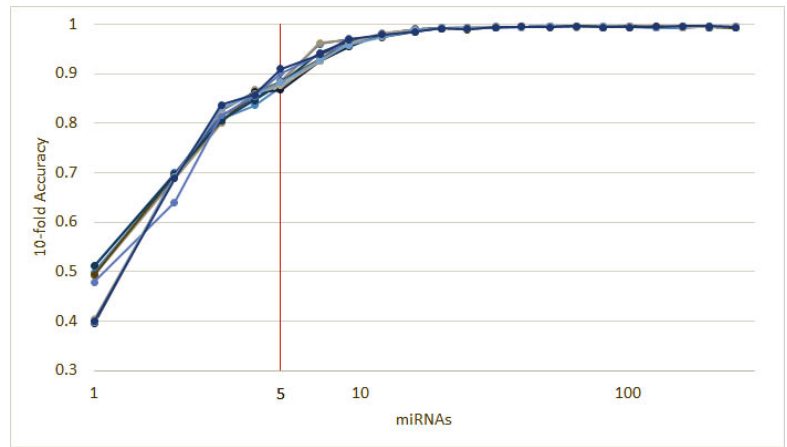
Figure 5. Ten runs of the heterogeneous ensemble recursive selection algorithm. From the 10 runs, the minimum number of necessary miRNA to have an accuracy above 90% is 5: hsa-let-7a, hsa-miR-23b,